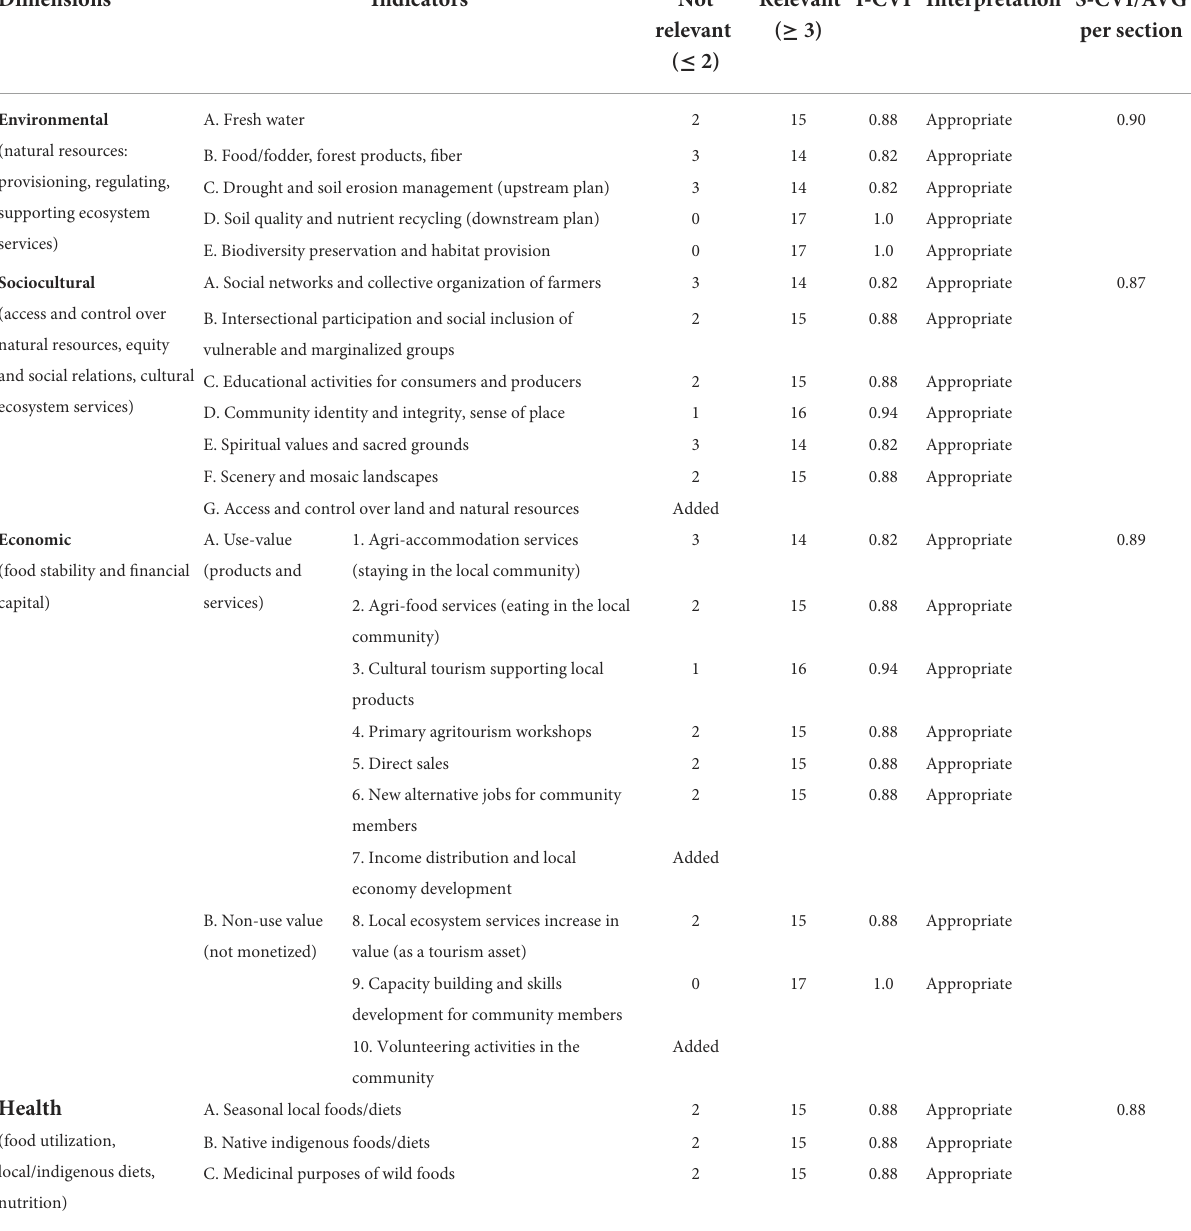
TABLE 2 Content validity index calculation, with non-relevant indicators removed (source: authors).